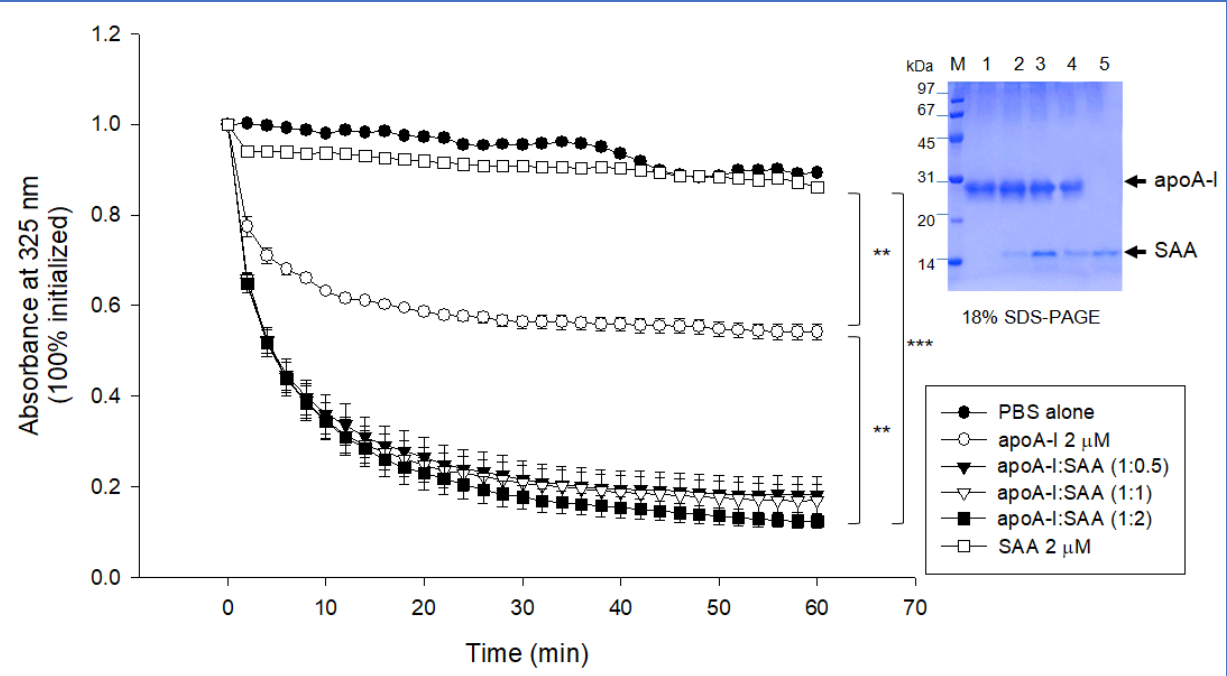
Figure 2. Phospholipid binding assay to compare the kinetics of apoA-I and serum amyloid A (SAA) with DMPC multilamellar liposomes. The absorbance at 325 nm was monitored at 24.5 °C at 2 min intervals. ** p < 0.01 between SAA alone and apoA-I alone; ** p < 0.01 between apoA-I alone and apoA-I:SAA (1:2); ***, p < 0.001 between SAA alone and apoA-I:SAA (1:2). The inset photograph shows electrophoretic patterns of the DMPC multilamellar liposomes containing apoA-I, SAA, and their mixture after a 60 min reaction (18% SDS-PAGE). Lane M, molecular weight marker (Bio-Rad low range); lane 1, apoA-I alone (final 2 μM); lane 2, apoA-I:SAA (1:0.5, molar ratio); lane 3, apoA-